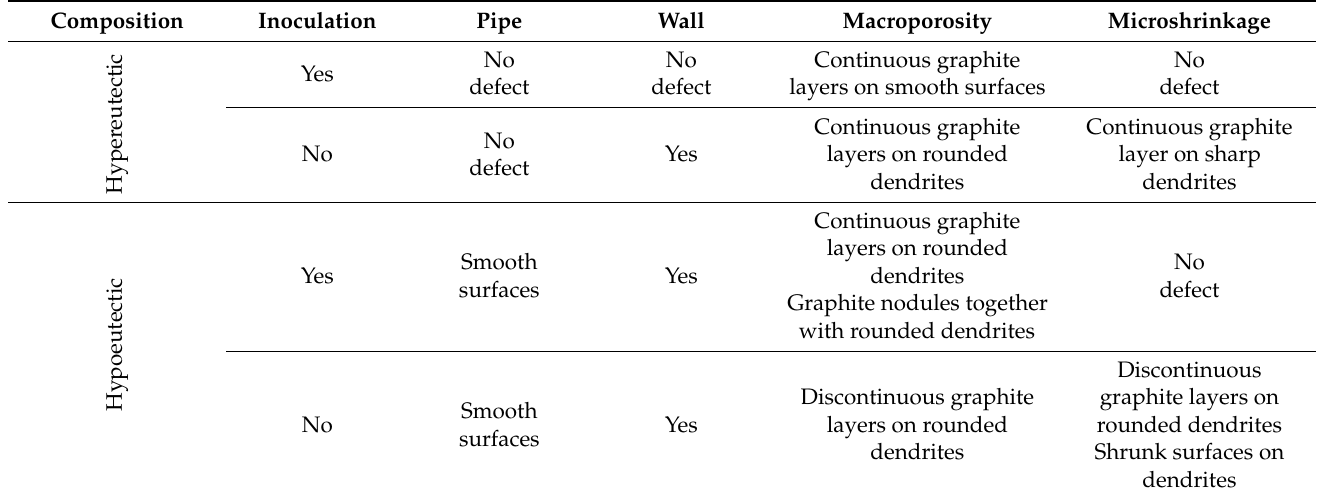
Table 1. Characteristics of different shrinkage defects found in four ductile iron alloys with different carbon equivalent contents and inoculation levels